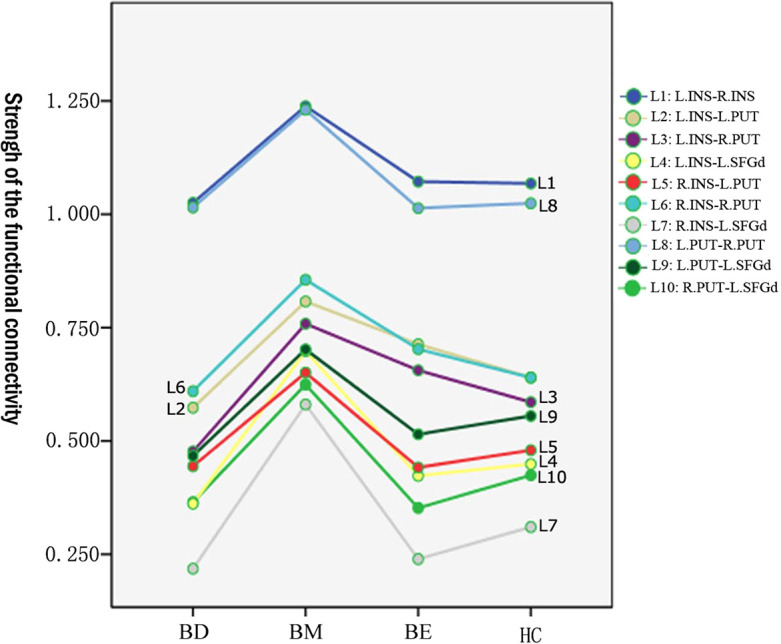
Means value of the functional connectivity strength of each link in the hate circuit in BM, BD, BE, and HC groups. BD, bipolar depression; BM, bipolar mania; BE, euthymic bipolar disorder; HC, healthy controls.